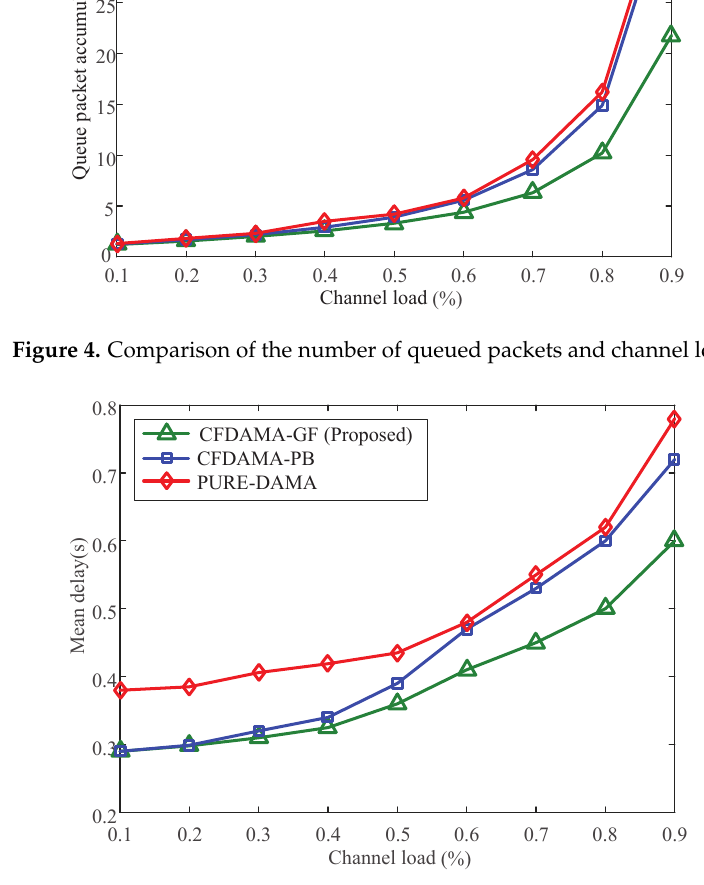
Figure 5. Comparison of average delay and channel